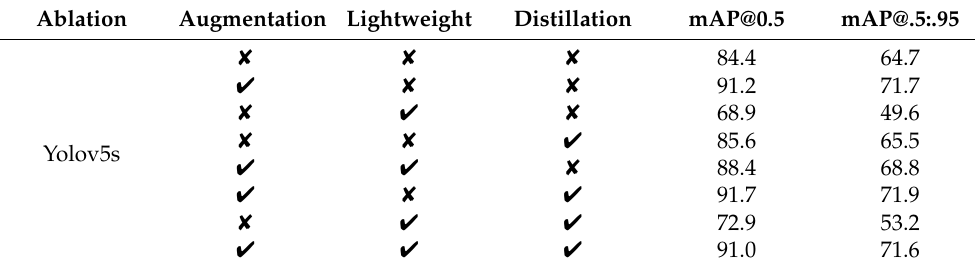
Table 7. Comparison of ablation experiments with different training methods on the TT100K